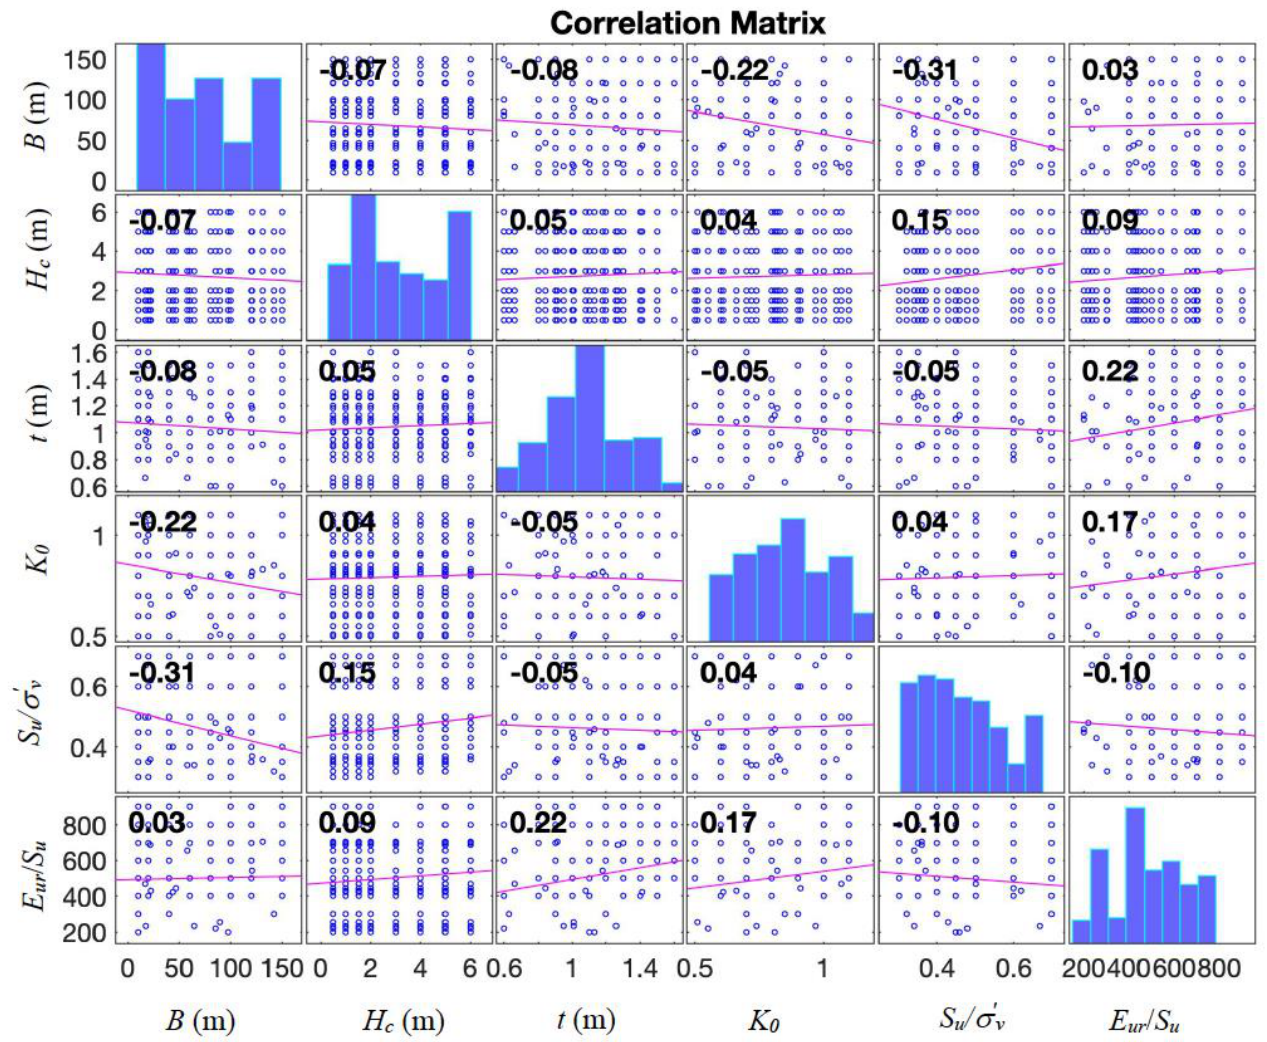
Figure 4. Correlation matrix of the database.